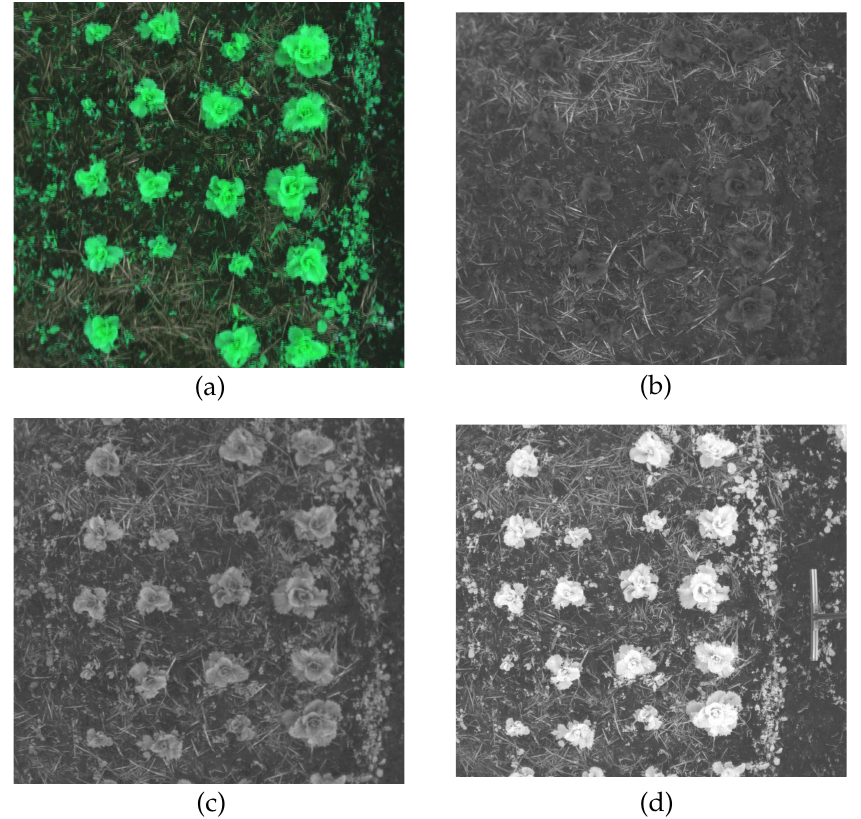
Figure 2. Dataset: (a) Fake Green. (b) Red band 660nm. (c) Green band 550nm. (d) Near Infrared band 790nm.